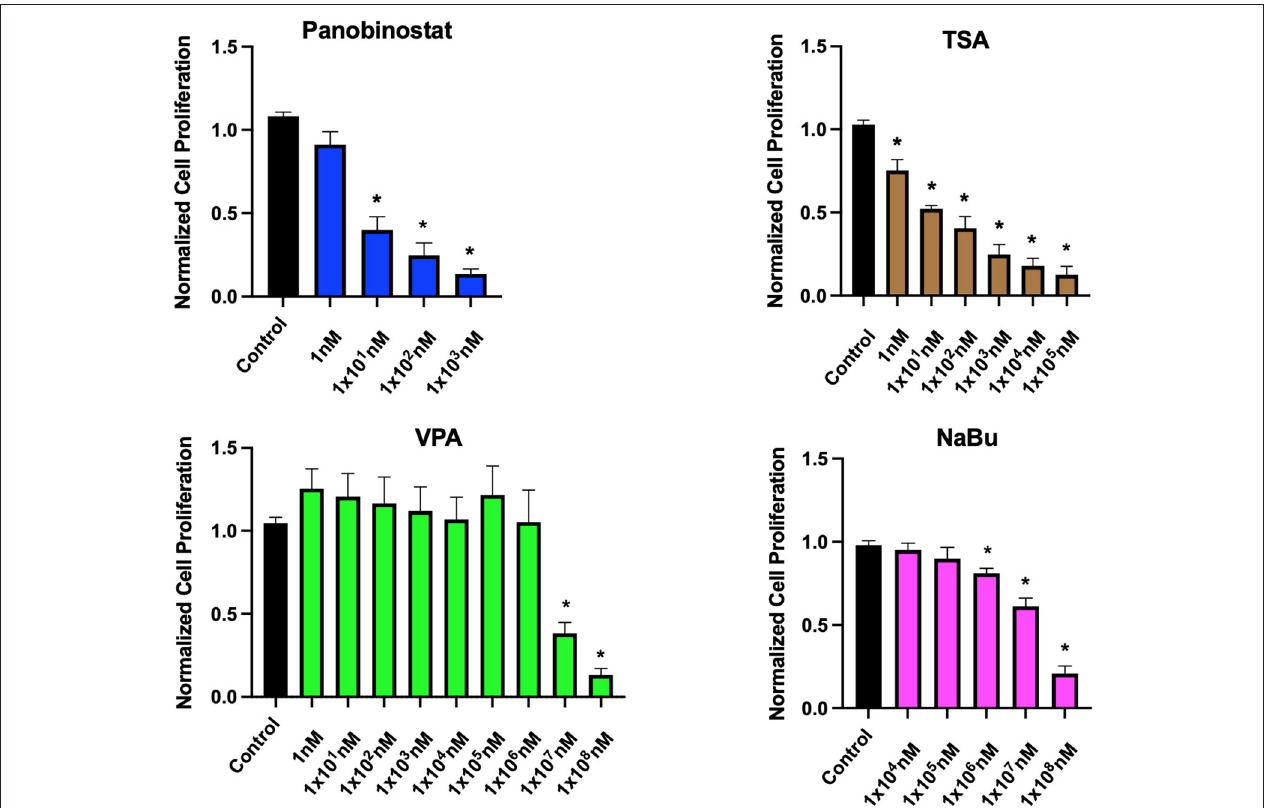
FIGURE 1 | Identification of noncytotoxic concentration ranges of HDACi compounds in CEF. CEFs were treated with a wide range of HDACi concentrations for 48h. Cells were counted, and data were normalized to non-treated control. Each experiment was conducted six times using three different CEF lines. Data are presented as mean ± SEM. Two-stage step-up method of Benjamini, Krieger, and Yekutieli for controlling false discovery rate was used for multiple comparison corrections. *False discovery rate adjusted p < 0.05.